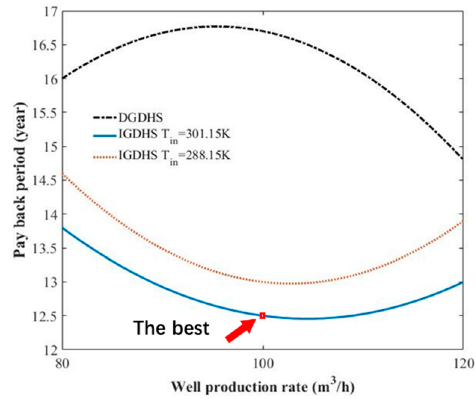
Figure 15. Investment payback period of different geothermal heating systems.